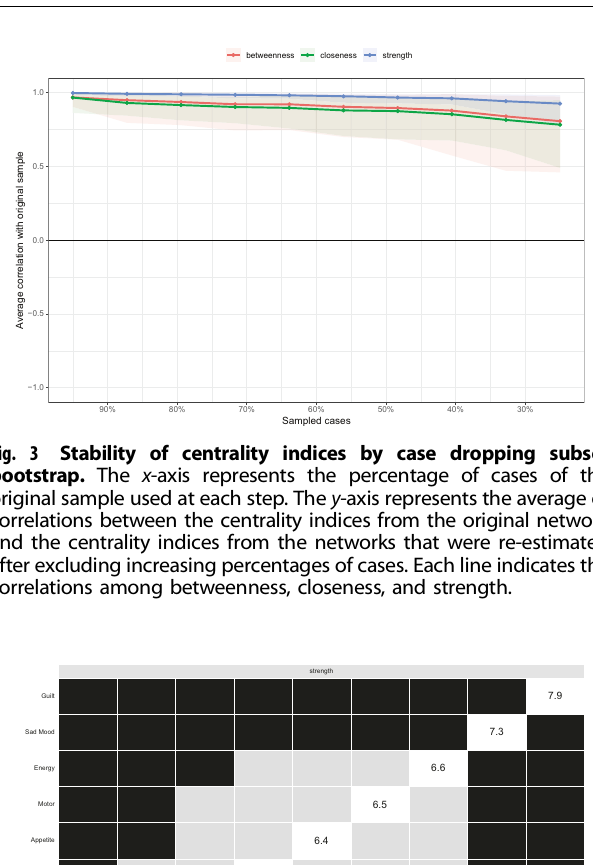
of the sample, the order of the symptoms in strength was still correlated with the original one ( r = 0.7)). Hence, we focused on the interpretation of symptom strength based on this network analysis. In terms of strength, Guilt, and Sad Mood were statistically stronger compared to other symptoms. Energy, Motor and Appetite appeared stronger than other symptoms in the network (Fig. 4). The bootstrapped difference tests also revealed that a large proportion of the comparisons among edge weights were statistically signi fi cant (Supplementary Fig. 2).